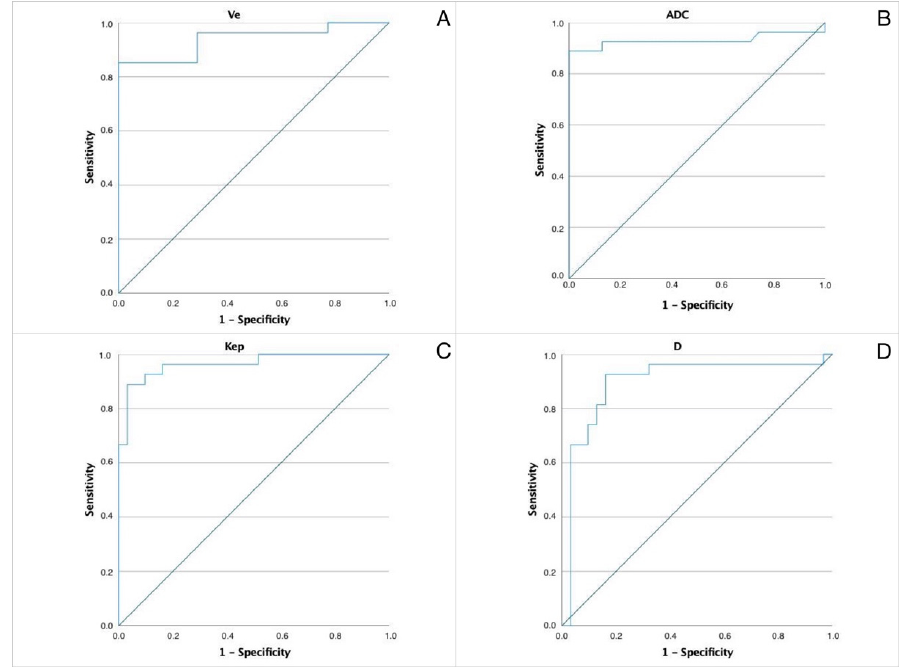
Figure 1. ROC of the most significant parameters allowing differentiation between WT and PA. AUC values and thresholds were for ( A ) ADC. AUC 0.931, threshold 1.05. ( B ) Pure diffusion coefficient ( D ) AUC 0.896, threshold 0.9. ( C ) Kep. AUC 0.964, threshold 1.1. ( D ) Ve. AUC 0.939, threshold 0.299.